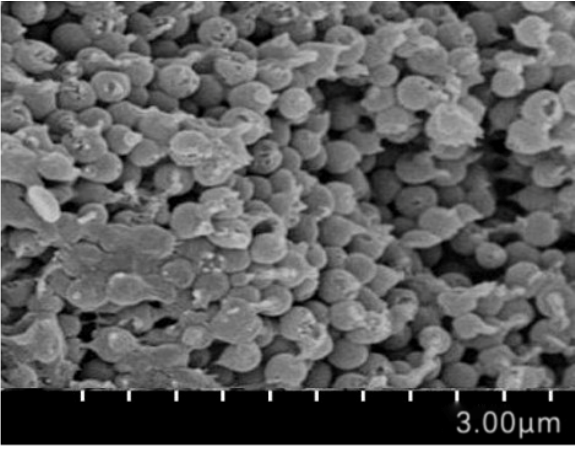
Figure 7. SEM photo of PAASM-CaCO 3.